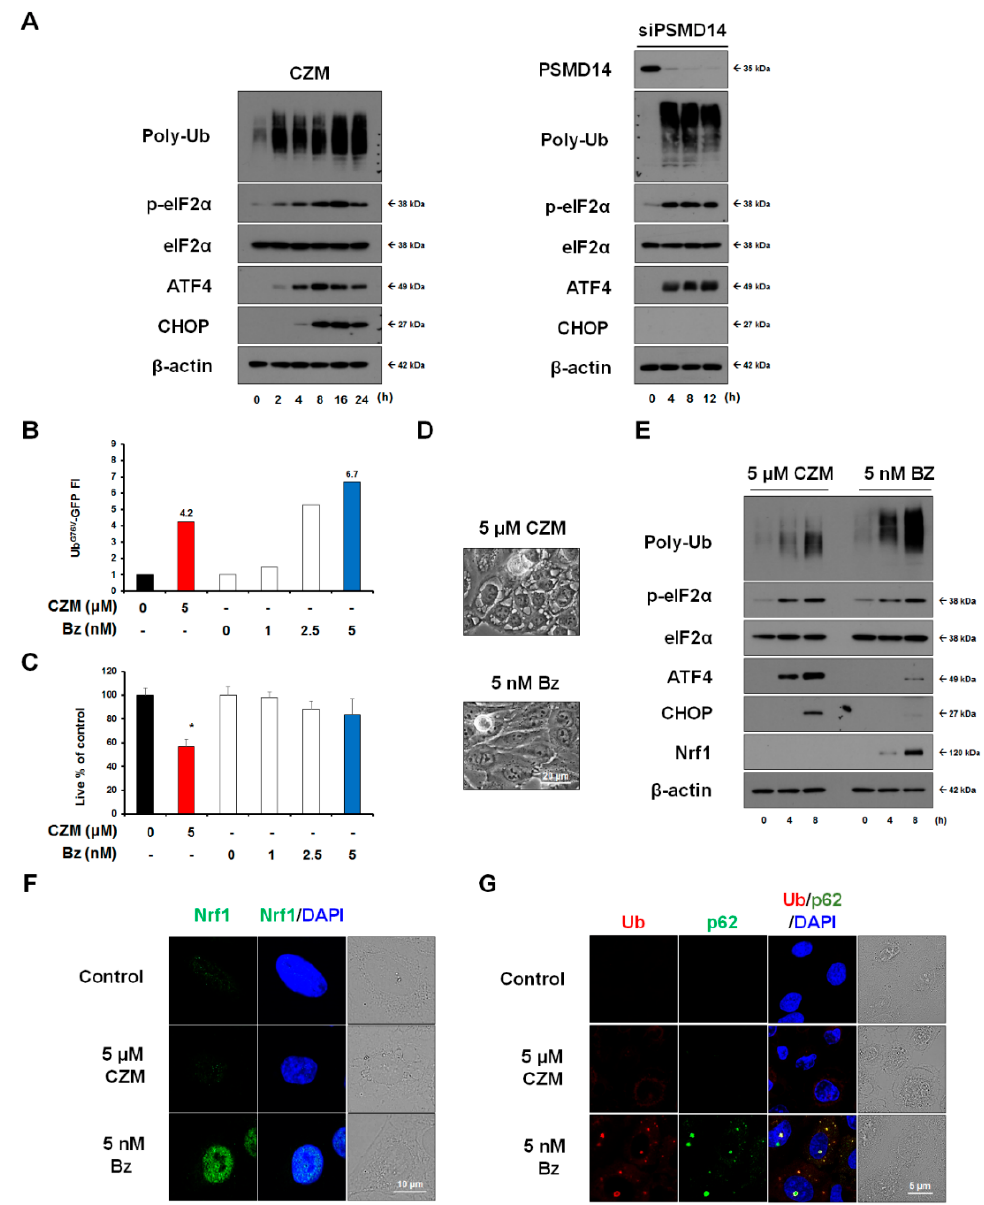
Figure 3. Proteasome inhibition alone is not sufficient to explain the anticancer effect of PSMD14. ( A ) Cell extracts were prepared from MDA-MB 435S cells treated with 5 µ M CZM or transfected with the siRNA against PSMD14 for the indicated time durations. Western blotting of the indicated proteins was performed using β -actin as a loading control. ( B ) MDA-MB 435S cells transfected with Ub G76V -GFP were treated with the indicated concentrations of CZM or Bz for 12 h, and the fluorescence intensity was assessed as described in Materials and Methods. ( C ) Viability was assessed using IncuCyte in MDA-MB 435S cells treated with CZM or Bz at the indicated concentrations for 24 h. * p < 0.001 vs. untreated cells. ( D ) MDA-MB 435S cells were treated with 5 µ M CZM or 5 nM Bz for 12 h and observed by phase-contrast microscopy. Bars, 20 µ m ( E ). MDA-MB 435S cells were treated with 5 µ M CZM or 5 nM Bz for the indicated time durations, and Western blotting of the indicated proteins was performed using β -actin as a loading control. ( F , G ) MDA-MB 435S cells were treated with 5 µ M CZM or 5 nM Bz for 12 h, and immunocytochemistry of the indicated proteins was performed. Bars, 10 µ m ( F ) or 5 µ m ( G ).